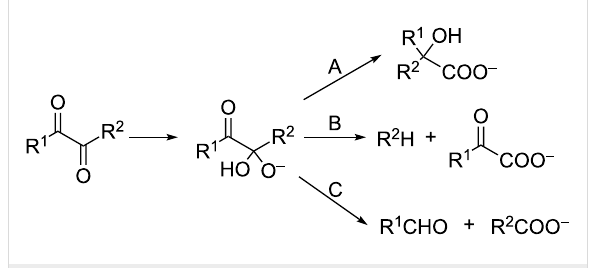
Scheme 1: Reactions of 1,2-dicarbonyl compounds with